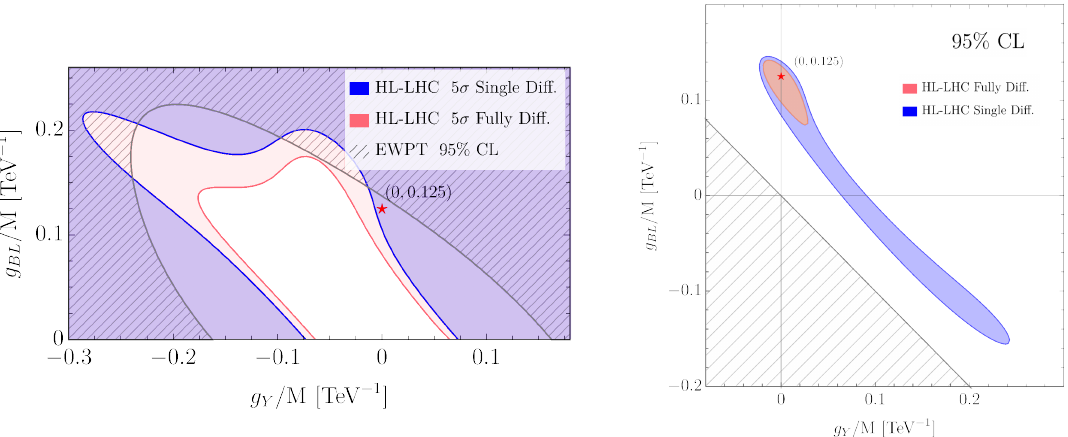
Figure 8 . Left panel: 5 σ discovery reach for HL-LHC and 95% CL EWPT exclusions. Right panel: 95% CL likelihood contours assuming the presence of a Z 0 with g BL /M = 0 . 12 TeV − 1 in the